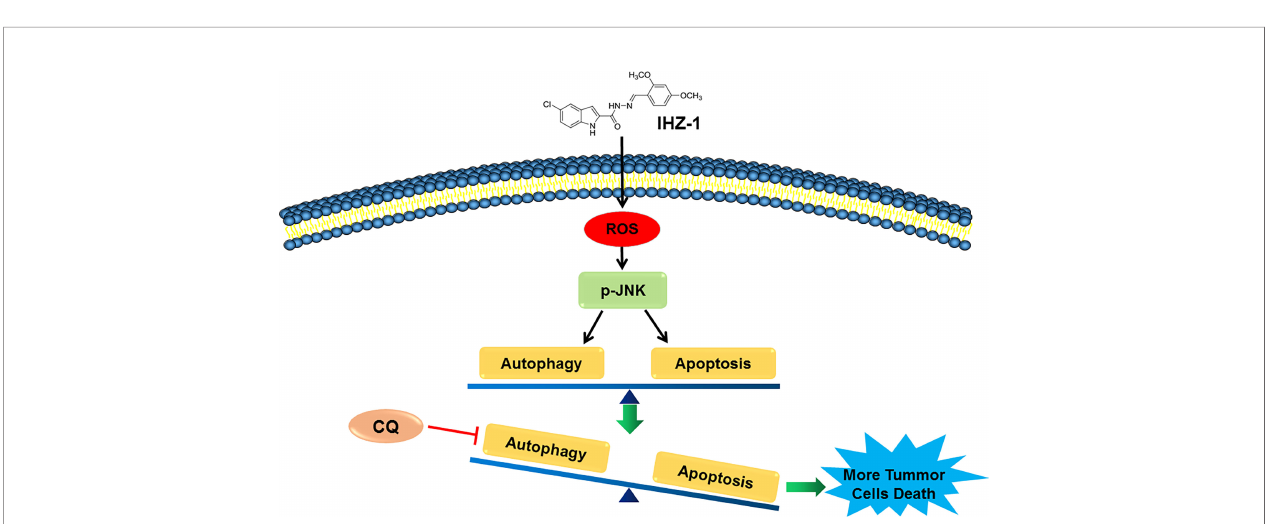
FIGURE 5 | The mechanism of IHZ-1 induced apoptosis and autophagy in HCC cells. IHZ-1 could accumulate ROS and induce autophagy in HCC cells, while inhibiting autophagy could enhance the apoptosis induced by